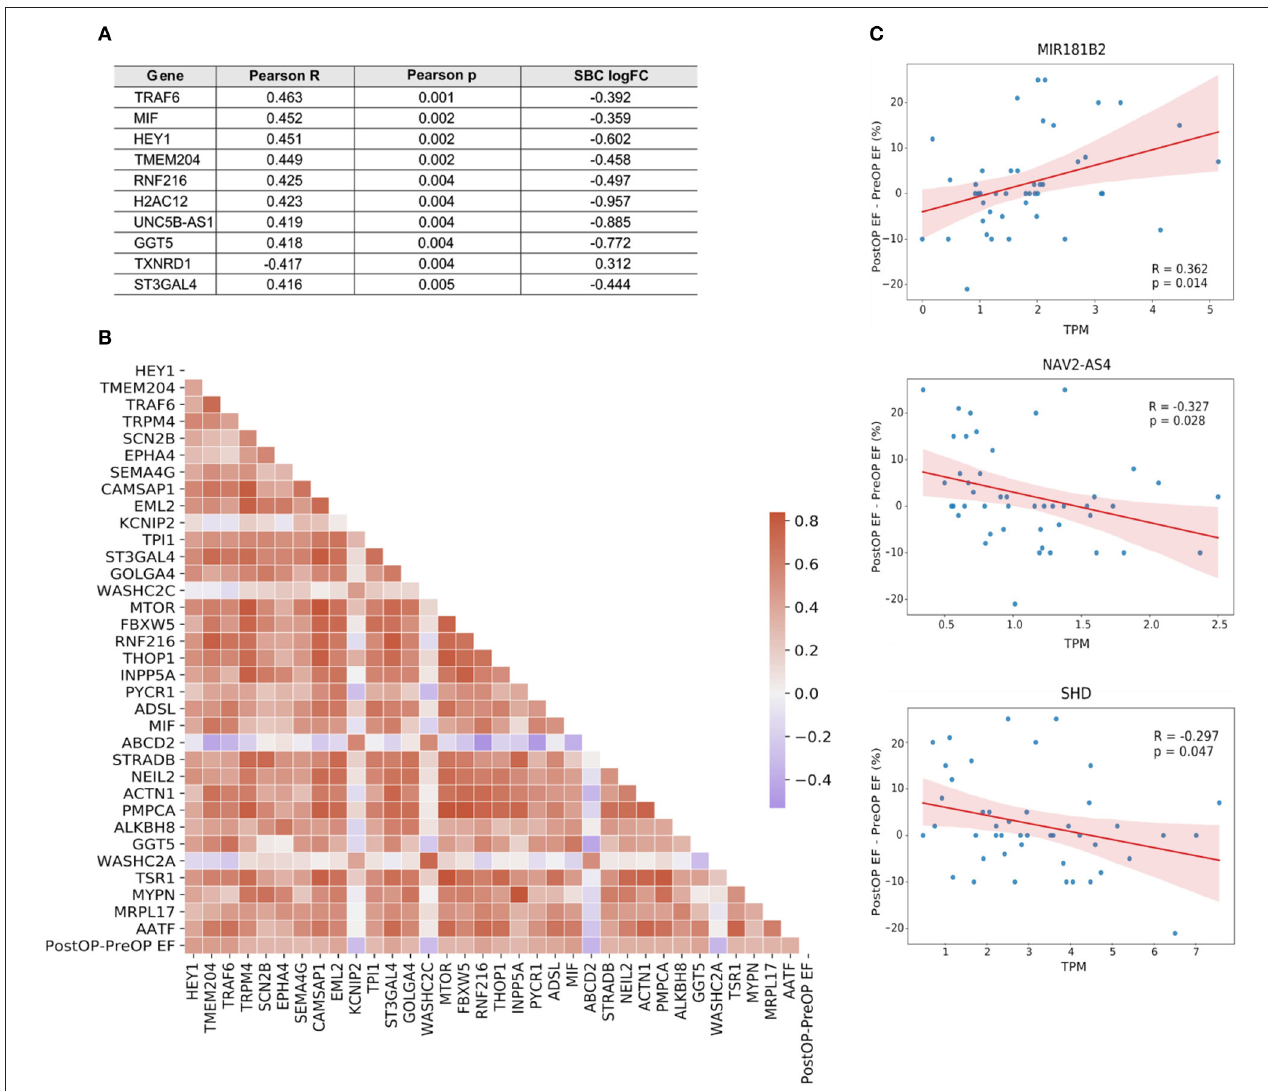
FIGURE 7 | (A) Top 10 genes linearly correlated with the change in EF following surgery. (B) Correlation heatmap of the genes mapped to a GO biological process. Color key, correlation coefficient. (C) Correlation plots of the top three genes with the highest |logFC| between surgery benefit